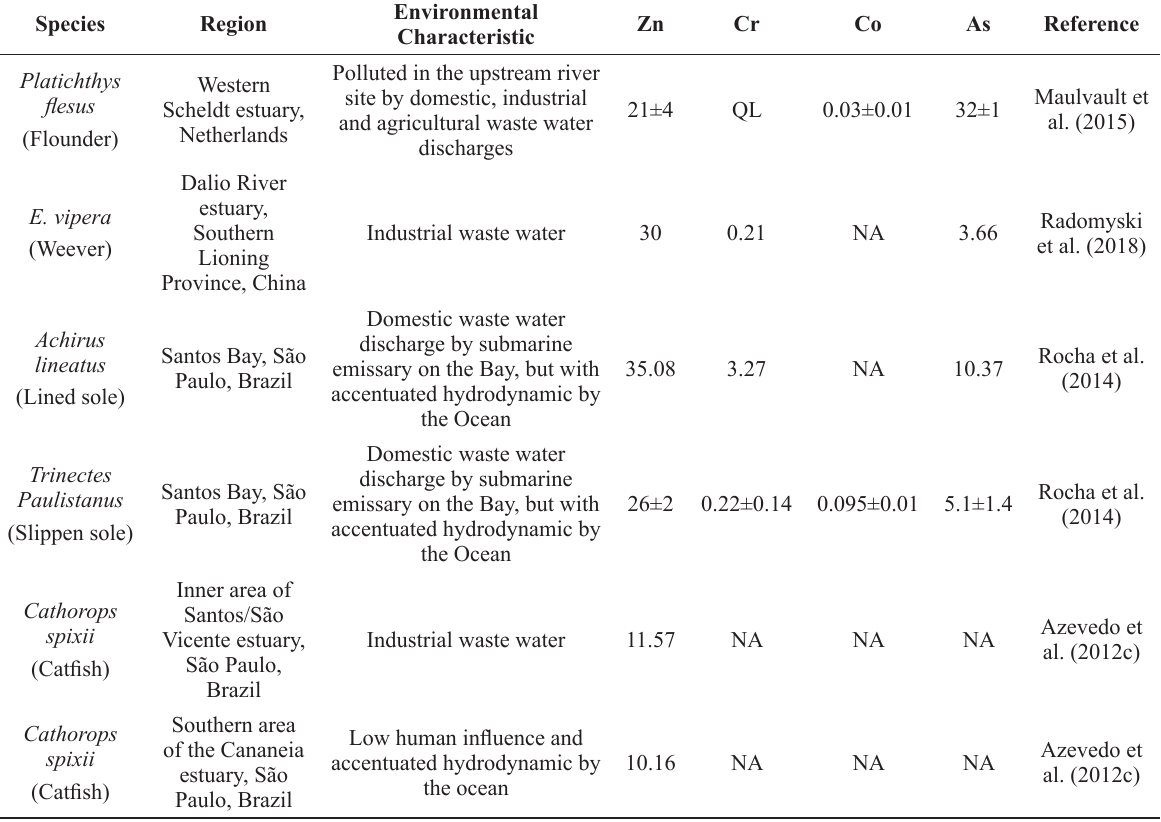
Zn, Cr, Co and As mean concentration ± standard deviation (mg Kg -1 ) in muscle tissue of fish species with demersal habitat from different sampling polluted and non-polluted areas on estuarine and coastal areas on the world. NA: not analyzed. QL: quantification